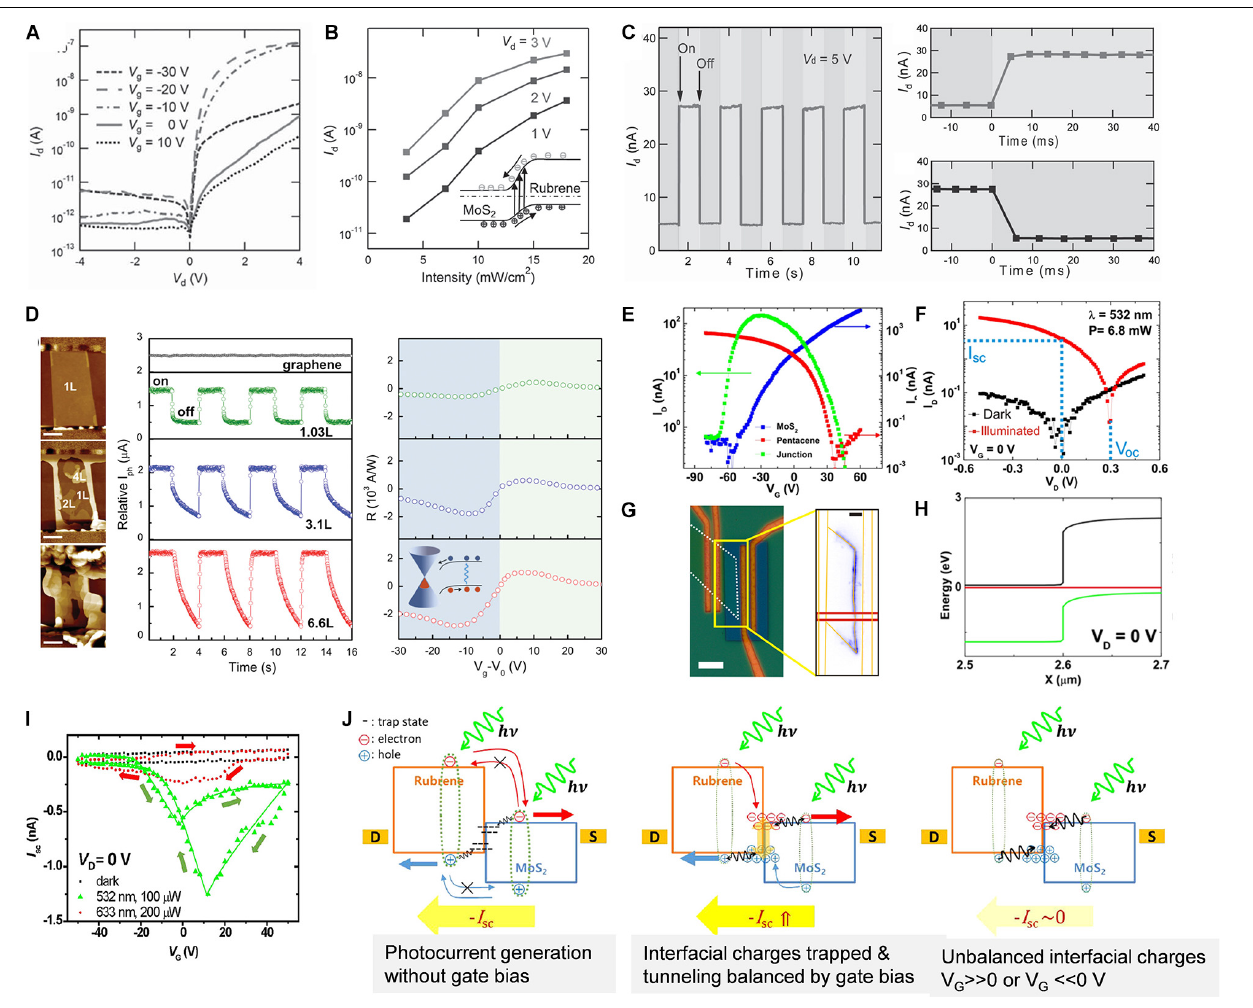
FIGURE 7 | Photodetector and photovoltaic OSC/2D hybrid FETs. (A) The output curves of the MoS 2 -rubene p-n junction. (B) Photocurrent as a function of incident laser intensity under different drain voltages. The inset shows the schematic for the photocurrent generation process of the p–n junction under light illumination. (C) Switch behavior of the MoS 2 /rubrene heterostructure. Reproduced from Liu et al. (2015) with permission from Copyright 2015 Wiley. (D) Photo-response of C 8 -BTBT/graphene phototransistors, and evolutions of the film morphology (left), dynamic photocurrent response (middle), and gate tunability (right) to photoresponsivity with increasing C 8 -BTBT thickness. Reproduced from Liu et al. (2016) with permission from Copyright 2016 Wiley. (E) Comparison of transfer characteristics between the single layer (pentacene and MoS 2 ) and the pentacene/MoS 2 heterostructure FETs. (F) Dark and illuminated I D − V D characteristics of the pentacene/MoS 2 heterostructure at V G = 0 V. (G) Spatial photocurrent map at V D = 0 V of the region indicated. (H) Horizontal band profiles near the edge of the overlapped pentacene/MoS 2 region ( X = 2.6 µ m). (I) I sc vs. V G characteristic curves of the MoS 2 /rubrene FET under dark conditions and light irradiation conditions. (J) Schematic illustrations of the photocurrent generation processes under focused laser irradiation at the MoS 2 /rubrene heterojunction under different